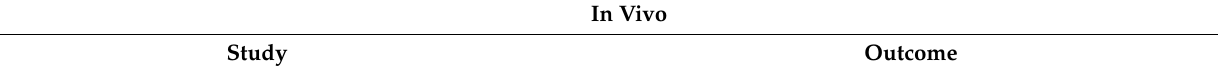
Table 1. Metabolic effects of thiamine in vivo and in